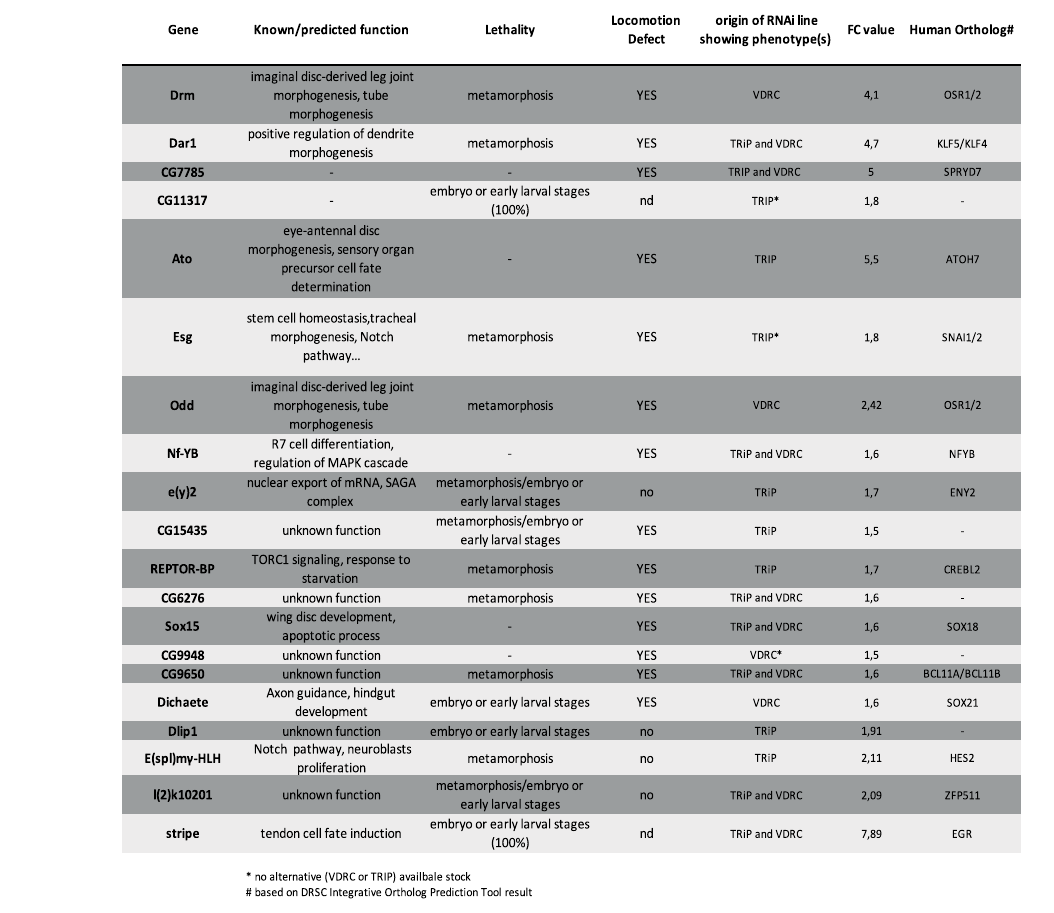
TABLE 2 | List of positive candidate genes based on RNAi screen.